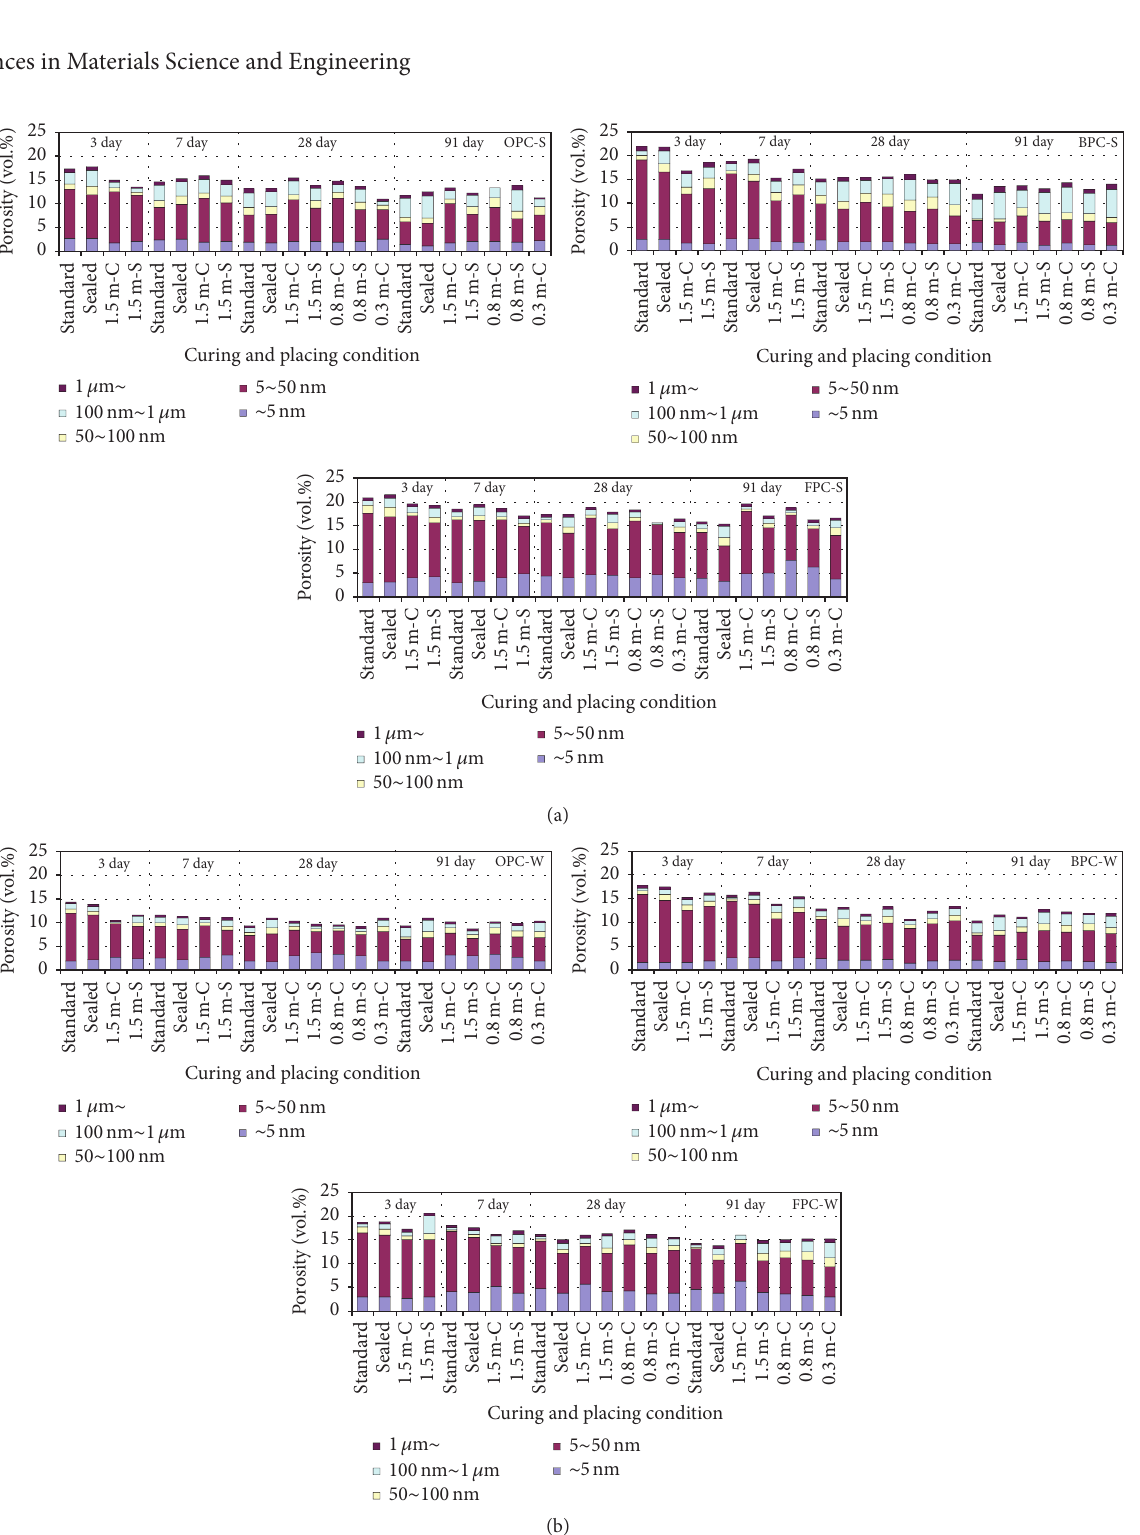
Figure 7: (a) The total porosity and pore size distribution of concrete in summer experiments. (b) The total porosity and pore size distribution of concrete in winter